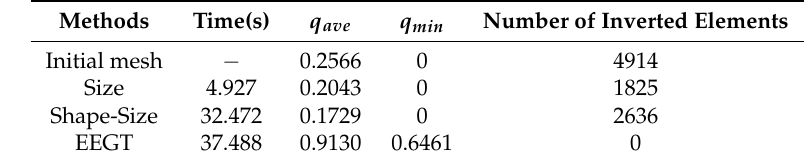
Table 3. Mesh quality statistics and the number of inverted elements for triangular mesh example. The mean ratio quality metric is used to measure the mesh quality.